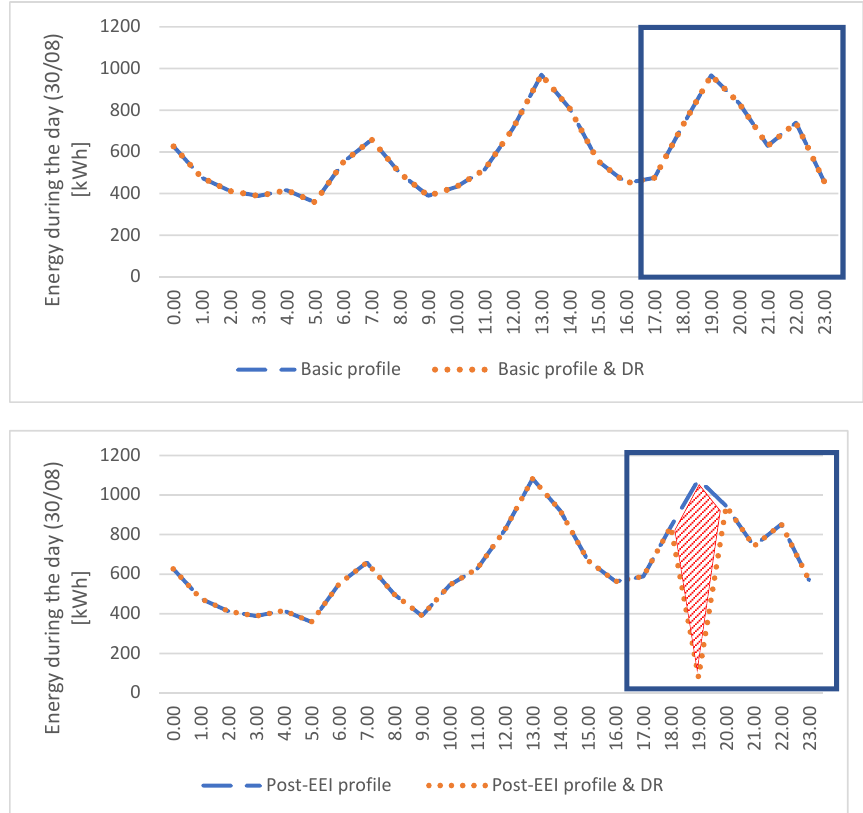
Figure 3. Comparison of basic and post-EEI profiles: DR requests (basic vs. HP + TI).